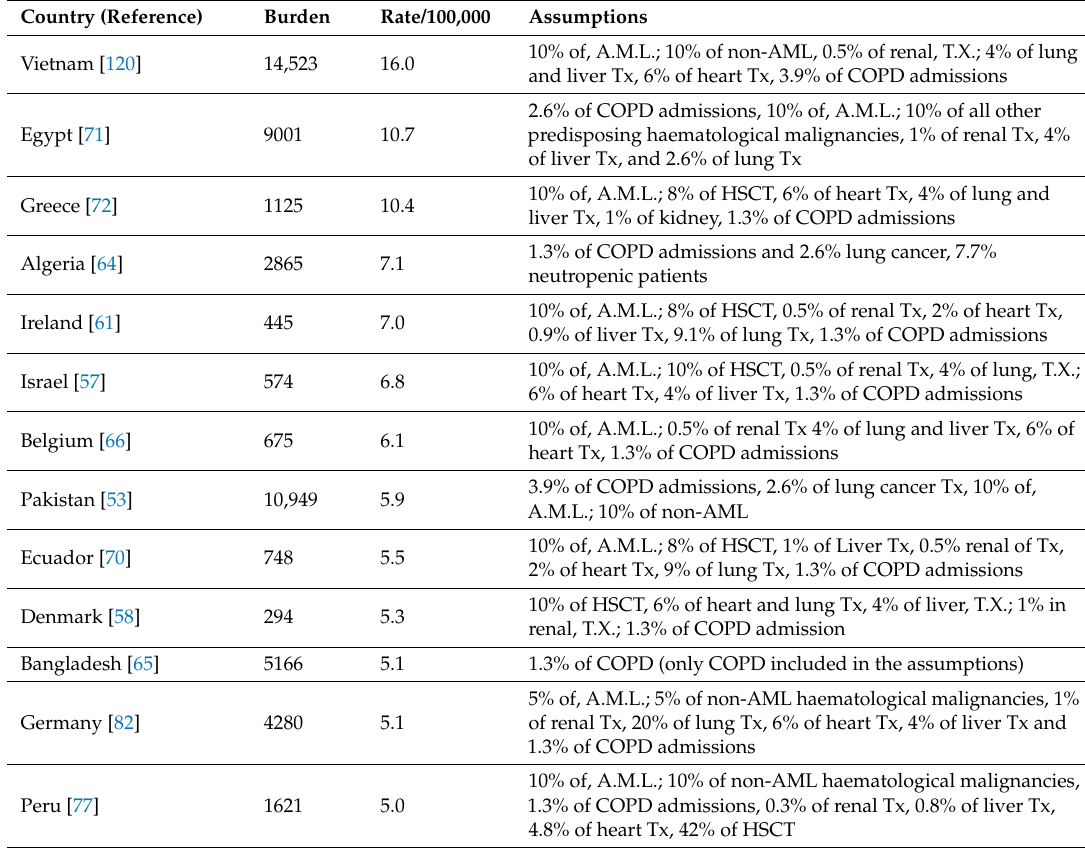
Table 3. Published country estimates of invasive